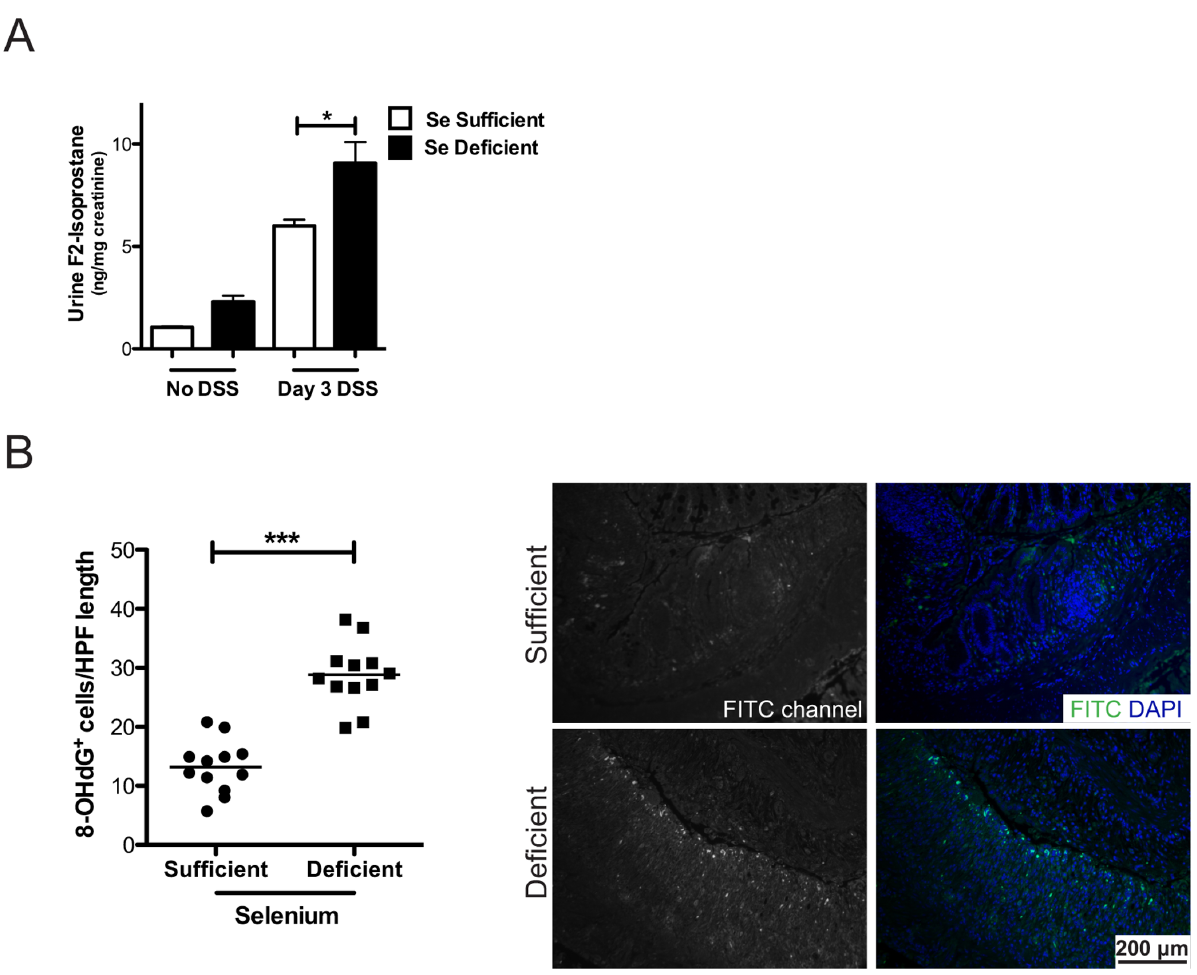
Figure 4. Selenium deficiency induces oxidative stress as measured by F 2 -isoprostanes and DNA damage. A. Selenium-sufficient (n=3, white bars) and -deficient (n=3, black bars) mice were given 3% DSS ad lib. and maintained in metabolic cages. Urine was collected at days 0 and 3 of DSS administration and F 2 -isoprostanes were measured and normalized to mg of creatinine. * P =0.05, 1-way ANOVA. B. 8-OHdG (FITC) staining was performed in Se-sufficient (n=12) and -deficient (n=12) mice post-DSS morbidity protocol and quantified based on number of positive cells per high-powered field (HPF, 40x) length (left). Representative staining is shown on the right. *** P , 0.0001.